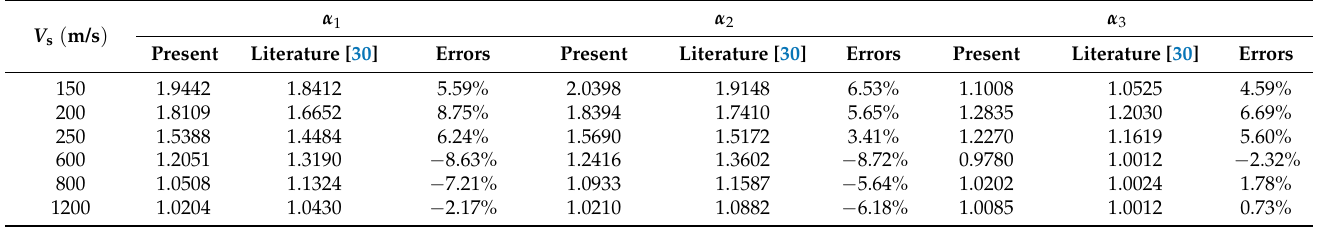
Table 2. Comparison of responses between present results and those obtained from an analytical model [30].